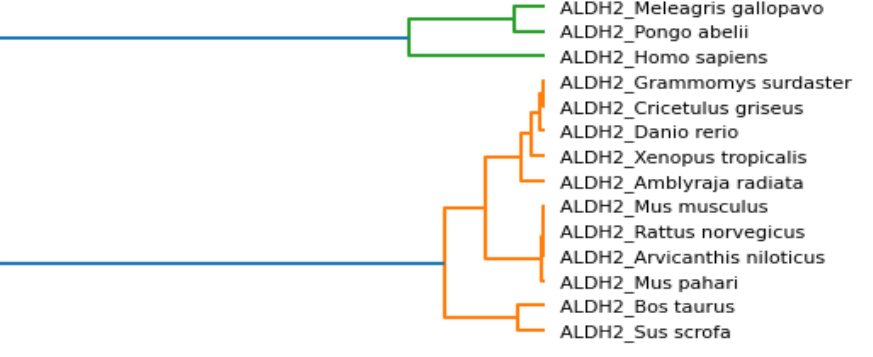
Figure 5. Hierarchical clustering phylogenetic tree based on physicochemical